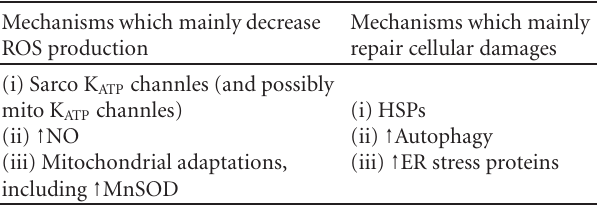
in the metabolic syndrome, type II diabetes, and aging [164, 165].